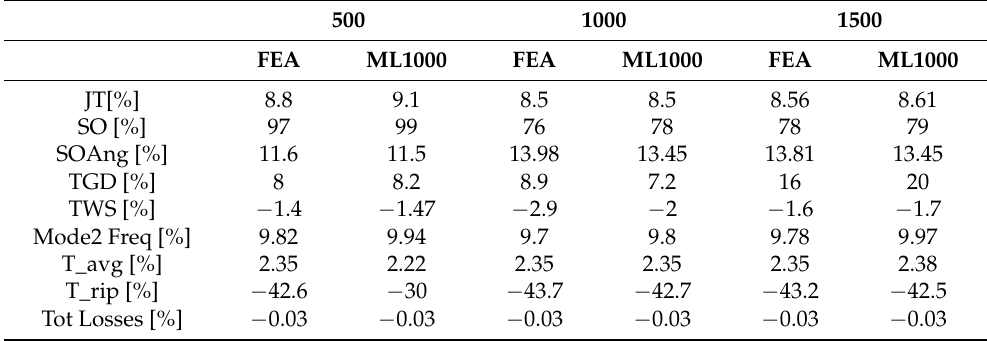
Table 7. ML1000 vs. FEA Optimisation results expressed as percentage difference from the nomi- nal design.